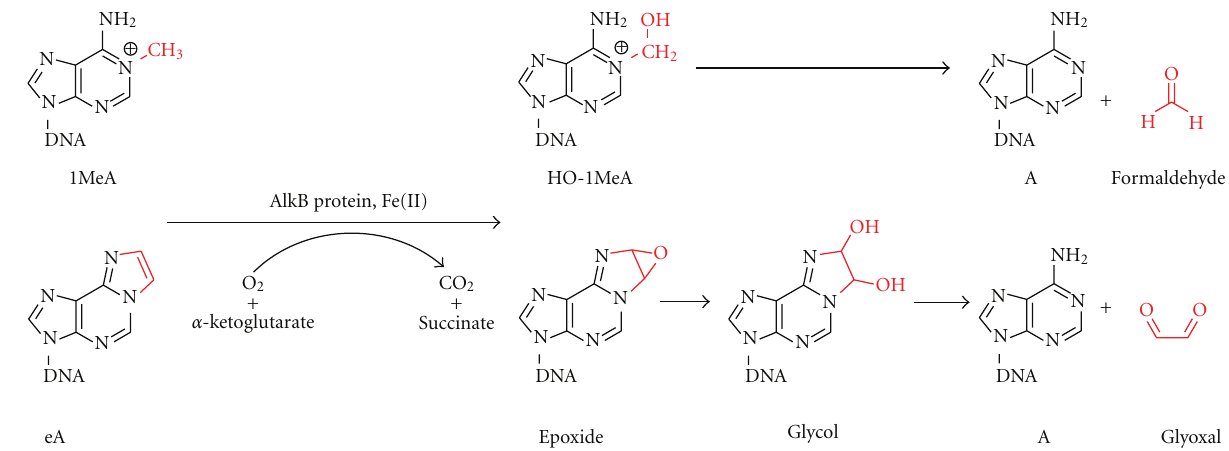
Figure 1: Proposed mechanisms and examples (1MeA and eA) of AlkB-mediated enzymatic repair of alkyl DNA lesions.